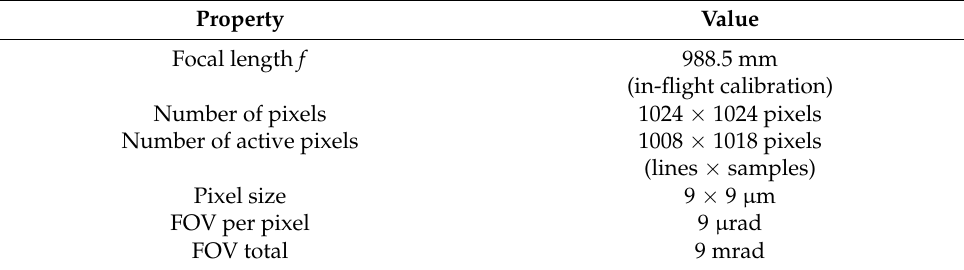
Table 3. Geometric properties of the SRC camera [26].